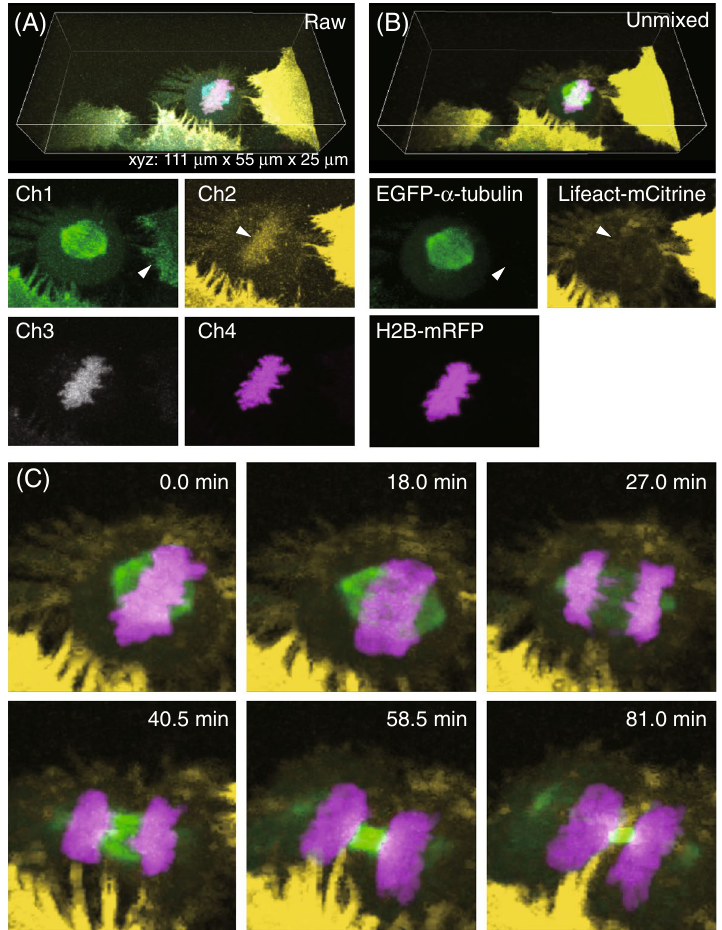
Figure 2. The xyzt-λ images of 3-color labeled human HeLa cells undergoing mitosis measured by the TPLSM-SD system. ( A ) Raw images at the time point of 0.0 min. Arrowheads represent leaking signals due to inter-channel cross-talks. ( B ) Calculated images by a linear unmixing method. Arrowheads representing the area where the leaking signals were decreased. ( C ) Time-lapse images of cell divisions during mitosis. Z -stacks (25-µm-thick) were taken at 0.5-µm intervals. In each sectioned image, the exposure times for 920-nm and 1040-nm excitations were 60 ms and 420 ms, respectively. The total time for xyz-λ image acquisition was 33 s, while the volume time-lapse interval was 90 s for 82-min measurements. The averaged laser power at the position of specimen for 920-nm and 1040-nm excitations were 162 mW and 37 mW,